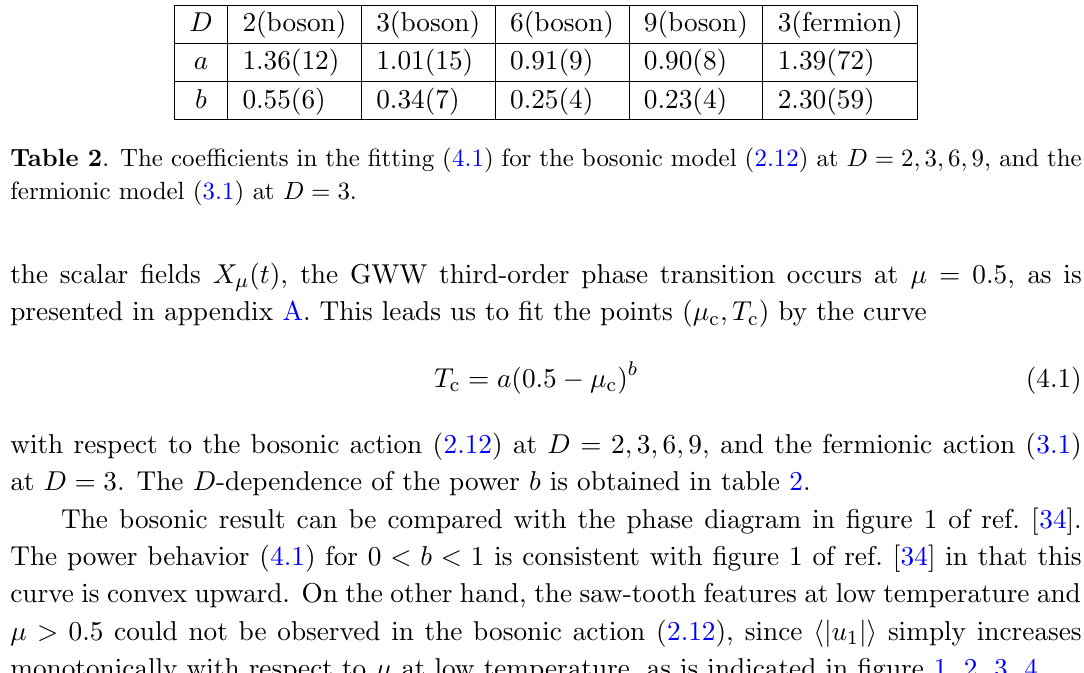
Figure 10 . The point ( (cid:22) c ; T c ) at which hj u 1 ji = 0 : 5. The result of the bosonic action (2.12) for D = 2 ; 3 ; 6 ; 9, N = 48 is indicated by \boson". The result of the action including the fermion (3.1) for D = 3, N = 16 is indicated by \fermion".